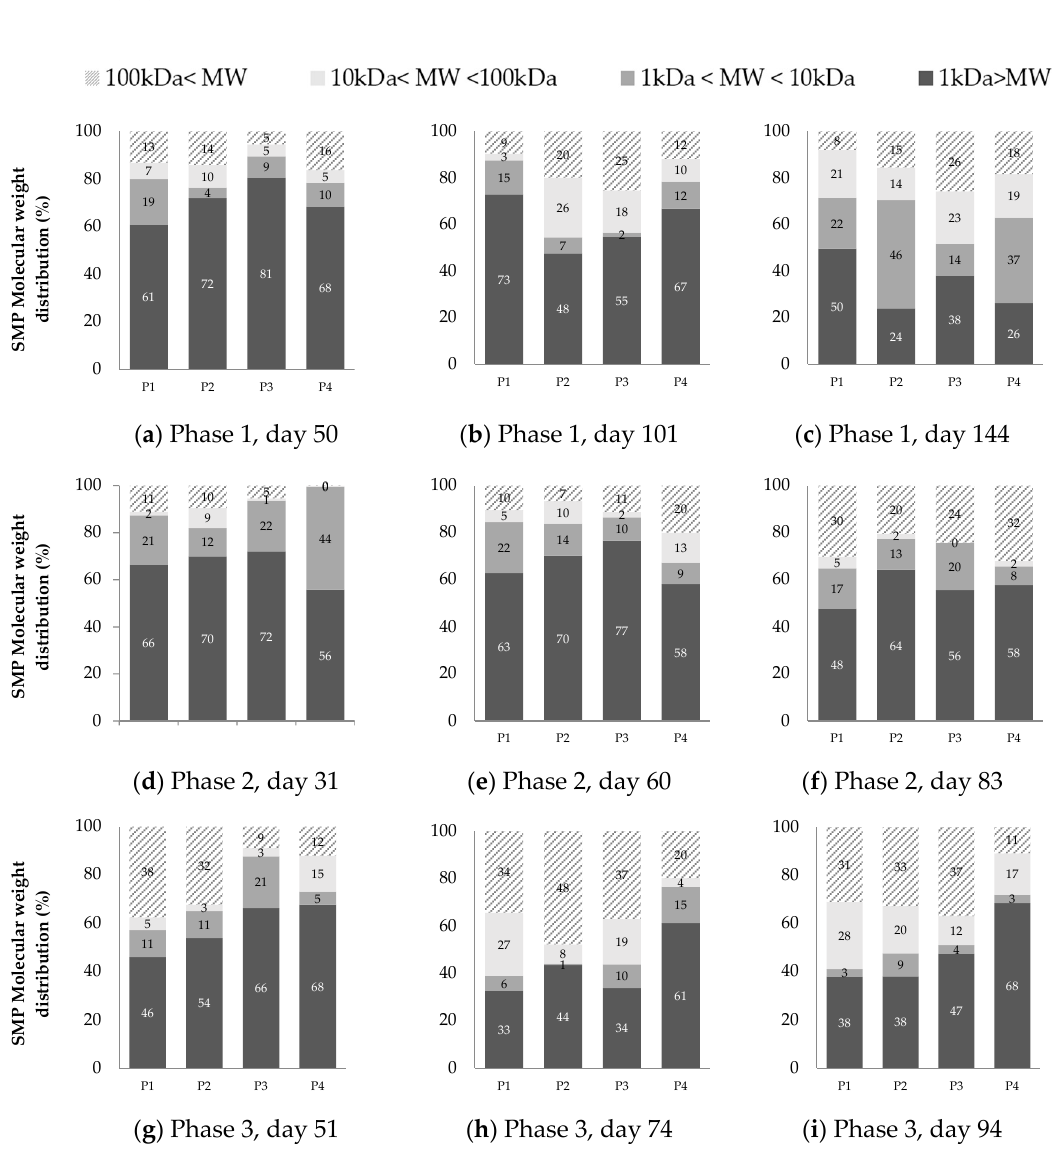
Figure 4. SMP molecular weight distribution. ( a – c ) correspond to phase 1; ( d – f ) to phase 2; and ( g – i ) to phase 3.